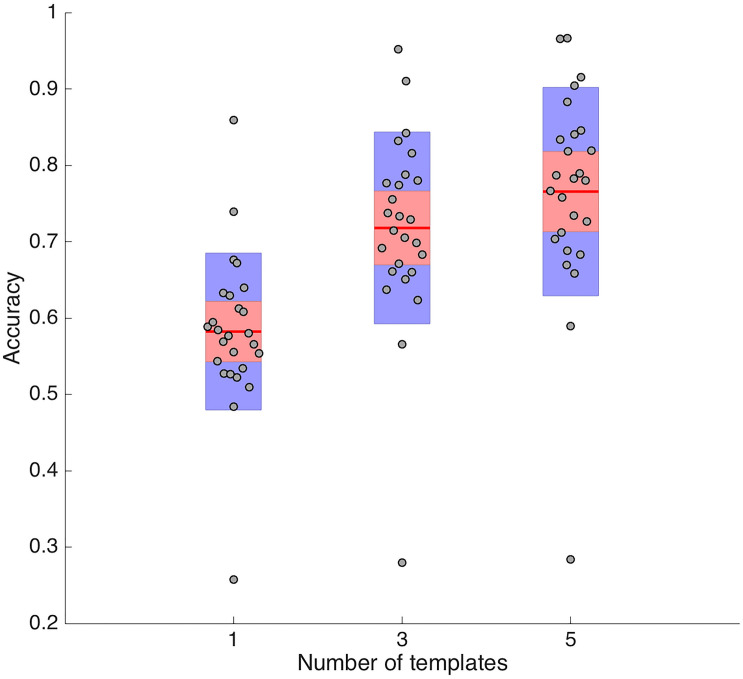
Electrode Labeling Accuracy. Box plots of the TP values for the different number of template(s): one template (left), 3 templates (middle), and 5 templates (right). The red line represents the mean value. Dots correspond to the accuracy obtained for each electrode set (26 in total). As the number of templates increases the mean accuracy also increases.